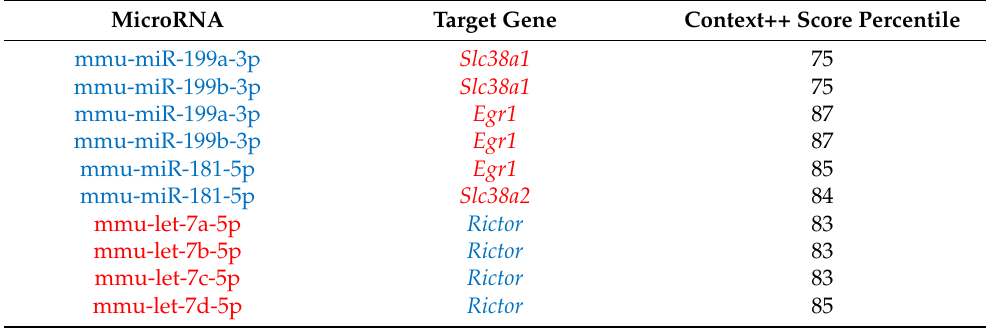
Table 1. Changes in microRNAs and their target genes in diapause embryos compared with those in reactivated and post-implantation